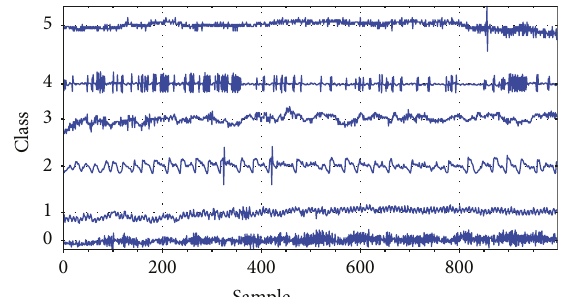
Figure 1: Example of records from each of the 5 classes of the EEG dataset.